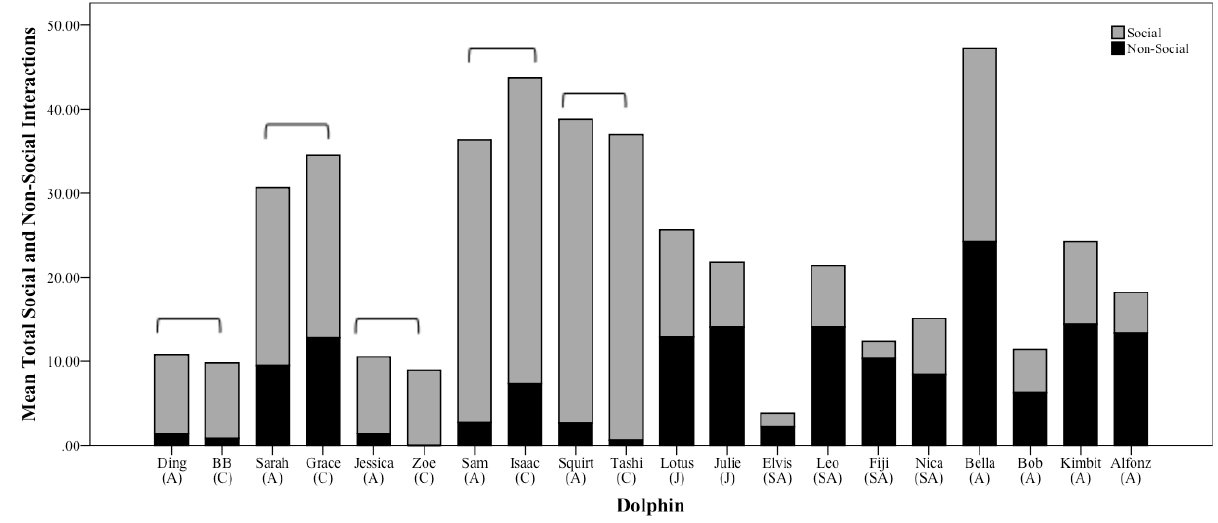
Figure 2. Mean number of social and non-social interactions with the apparatus per trial ( n = 10) exhibited by each subject ( N = 30), identified as individuals and their age class: calf (C), juvenile (J), subadult (SA), and adult (A). Brackets delineate mother-calf